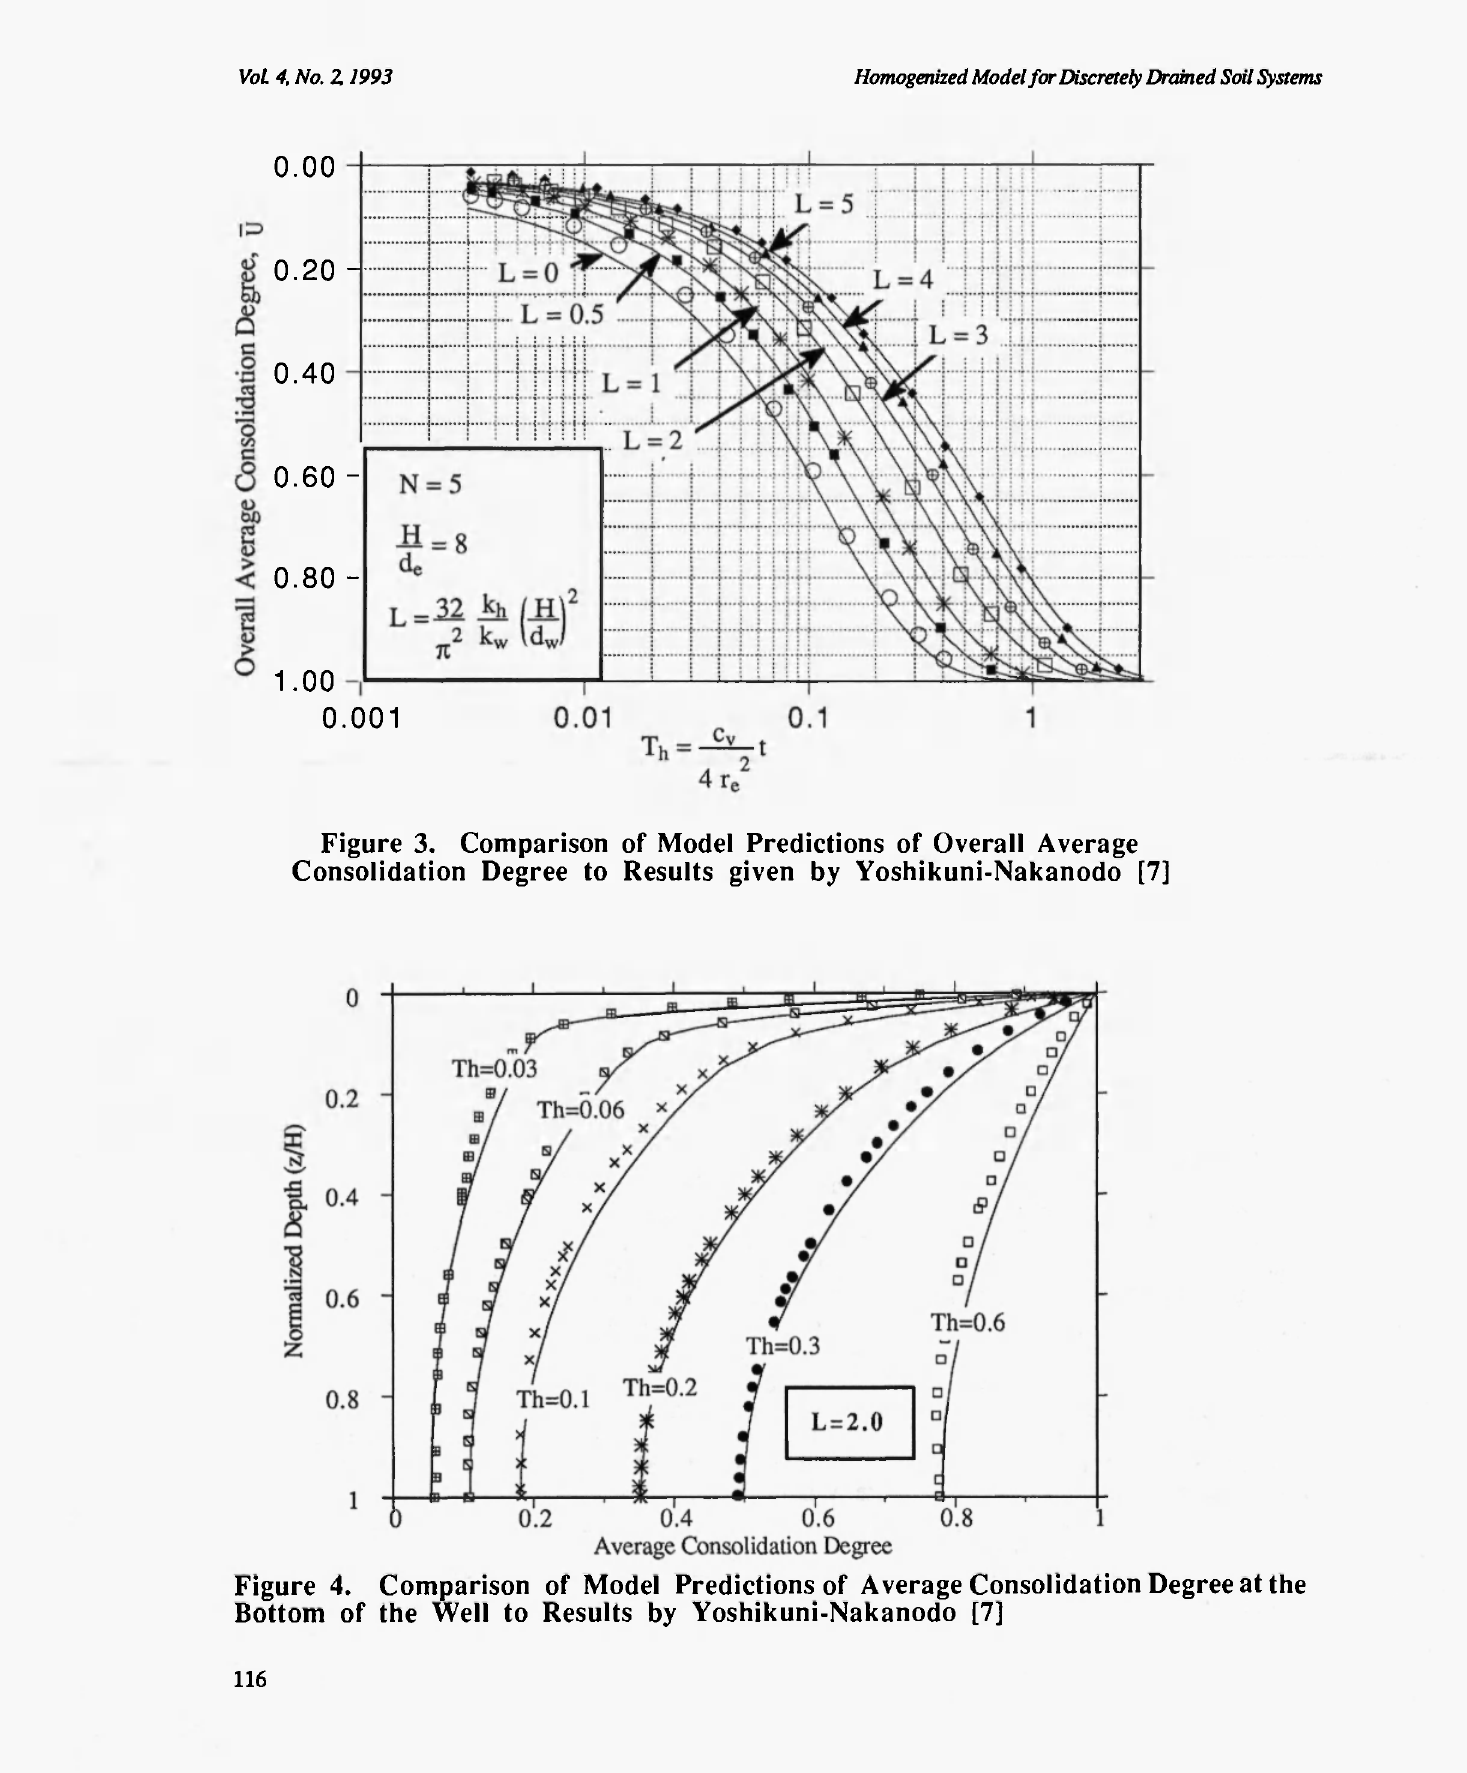
Figure 4. Comparison of Model Predictions of Average Consolidation Degree at the Bottom of the Well to Results by Yoshikuni-Nakanodo